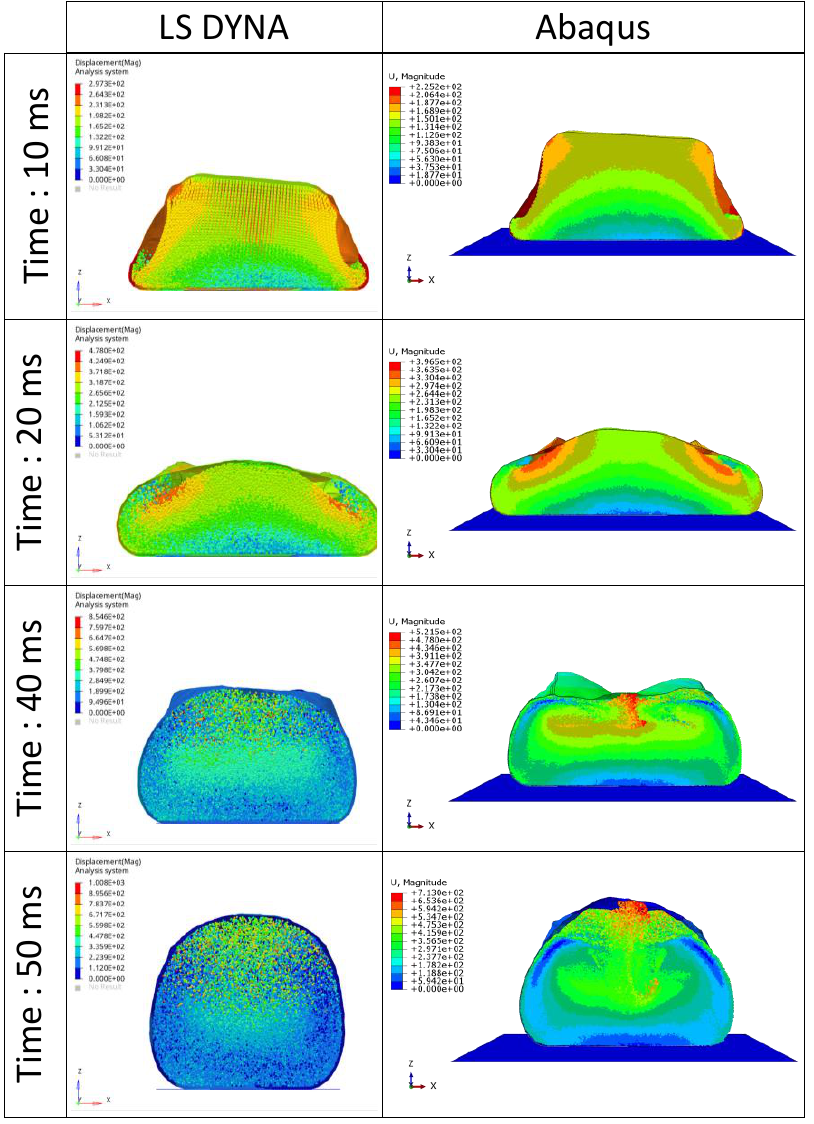
Figure 8. SPH global displacement field. Left: Ls-Dyna model; right: Abaqus model.